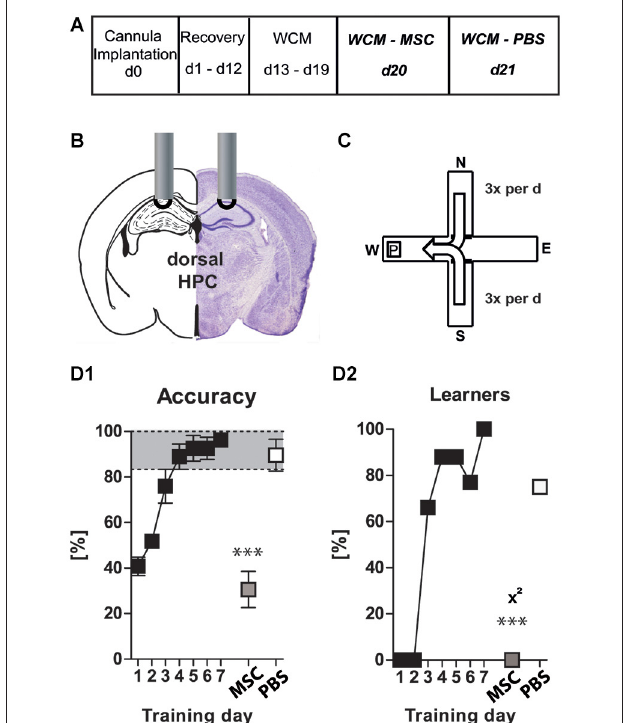
FIGURE 5 | Experiment V: Muscimol–Control : (A) timeline for Experiment V: stereotaxic cannula implantation at d0, recovery for 12 days, WCM training d13–19, Muscimol treatment and WCM recall d20, PBS Treatment and WCM recall d21; (B) Cannula position for muscimol/PBS injections: dHPC, bilateral, l 1.3; a-p − 1.8; v 1.0 mm from Bregma; injection of 0.5 µ l MSC (125 µ g/ µ l) or PBS per hemisphere; (C) basic schema of WCM; (D1 + D2) learning parameters for WCM. Data presented as mean ± SEM; ∗∗∗ p < 0.001 (chi 2 test or paired Student’s t -test). dHPC = dorsal hippocampus; MSC = muscimol; PBS = phosphate-buffered